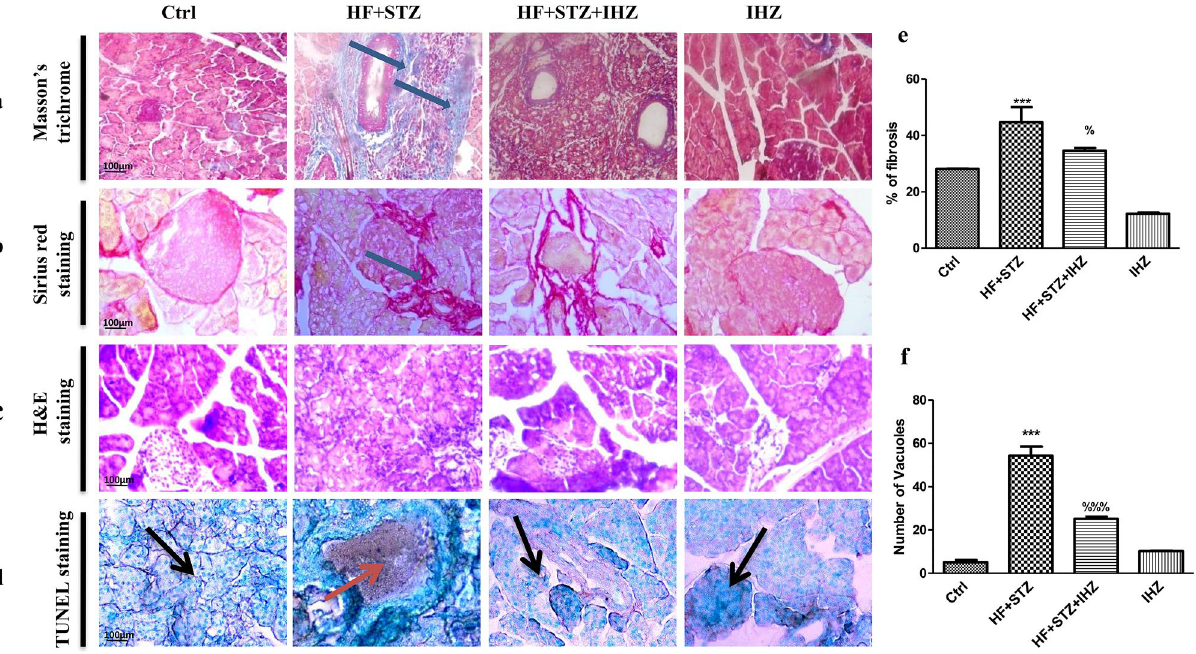
Figure 3. IHZ attenuates islet damage (apoptosis) and fibrosis in pancreatic tissue of diabetic rats. ( a , b ) Sections of pancreatic tissue stained with Masson’s trichrome and Picro-Sirius red staining, respectively to detect fibrosis (blue coloration, red coloration marked with arrows). ( c ) Sections of pancreatic tissue stained with H&E staining to detect cell morphology and number of vacuoles. ( d ) Representative images of TUNEL assay to assess apoptosis (apoptotic sites marked with arrows). ( e , f ) Quantitative data from figures ( a/b , c ). Data is presented as mean ± SD of n = 3 animals for each group. ***P < 0.001 vs control group, %P < 0.05, %%P < 0.01 vs HF + STZ